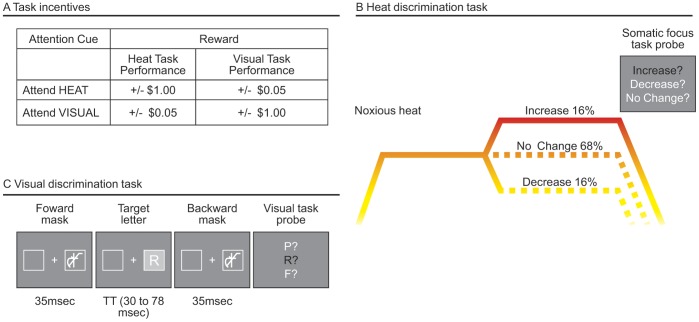
Somatic Focus manipulated with incentivized discrimination tasks.A. Task incentives. In order to provide incentive to follow the attention task cue (“Attend HEAT” or “Attend VISUAL”), we manipulated monetary payoffs, based on task performance. On Somatic Focus trials, participants were rewarded more for correct heat discrimination ($1.00) than visual discrimination ($0.05). Likewise, participants were penalized more for incorrect heat discrimination (-$1.00) than incorrect visual discrimination (- $0.05). On Visual Focus trials, the payoffs were reversed. Payoffs were determined from a subset of trials (20). The maximum additional reward compensation a participant could earn was $21 and the minimum was $0. B. Heat discrimination task. On 16% of trials the temperature increased by 1 degree, on 16% it decreased by 2 degrees (reductions are more difficult to detect based on piloting), and on the remaining trials there was no change. There were no changes in temperatures calibrated to elicit moderate pain (level 5), so we could test the effects of expectancy and attention on a constant, moderate level of pain stimulation. There was an equal distribution of increase, decrease, and no change trials on temperatures calibrated to elicit high and low levels of pain. In the no change trials, the stimulus intensity remained at the level determined to elicit a low (level 3) or high (level 7) amount of pain, based on the calibration procedure. For low and high pain, we used the levels 3 and 7, instead of 2 and 8, so that the decrease trials in the low-pain condition, and the increase trials in the high-pain condition would still be within the temperatures calibrated to elicit low and high pain (2 and 8, respectively). Participants reported no awareness of these contingencies in debriefing. C. Visual discrimination task. On each trial of the visual discrimination task, one of 20 consonants (excluding X) was briefly presented (for durations of 30 to 79 msec, depending on each participant’s calibrated performance) and masked immediately before and after by a mask constructed of overlapping letters. Letters and masks were presented directly to the left or right from a central crosshair. Participants had to determine which letter was presented on each trial.